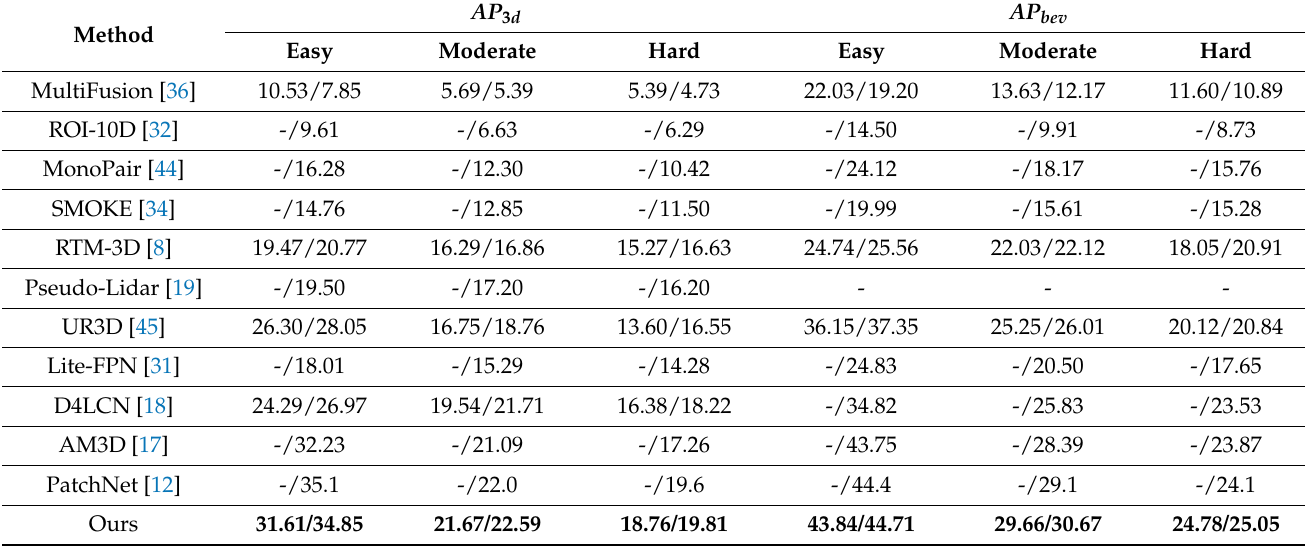
Table 1. Comparisons of and on KITTI val1/val2